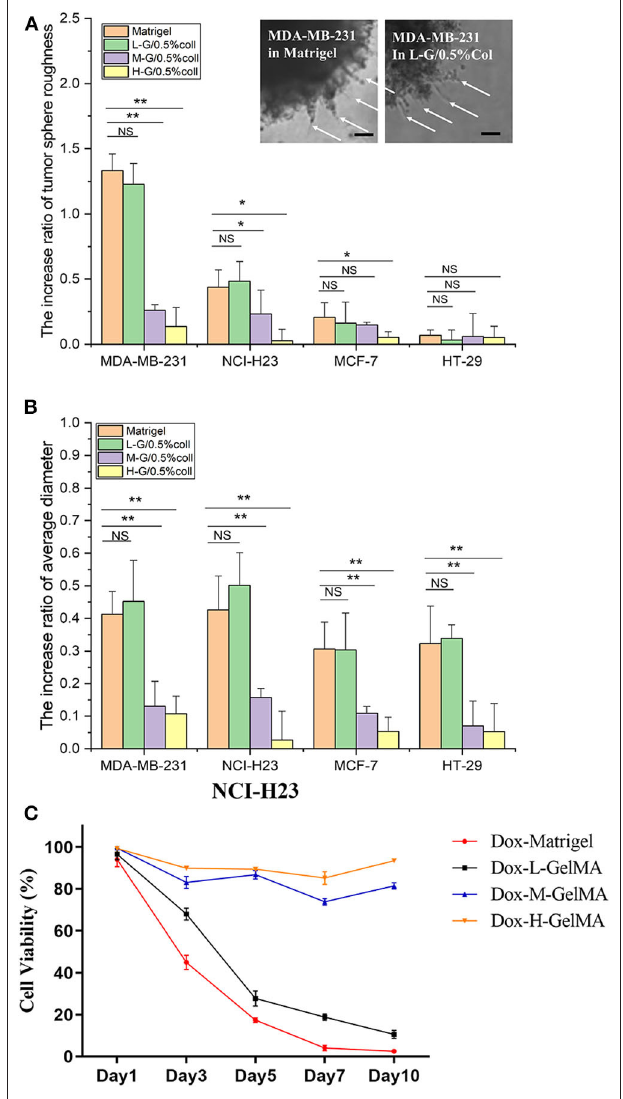
FIGURE 4 | Quantitative analysis of tumor spheroid behavior in composite hydrogel. (A,B) The spheroid roughness and size comparison of four kinds of tumor microspheres in Matrigel and composite hydrogel. Inserted image shows the invadopodia-like protrusions inside of the both Matrigel and L-G-C composite hydrogel. (C) The drug efficacy to cancer cells tested in Matrigel and L-G-C composite hydrogel. N = 3 for each experiment. Error bars indicate the S.E.M of the data variation. Significance were indicated with * P < 0.05, ** P < 0.01 (one way ANNOVA with Tukey back test). Scale bar: 50 µ m.